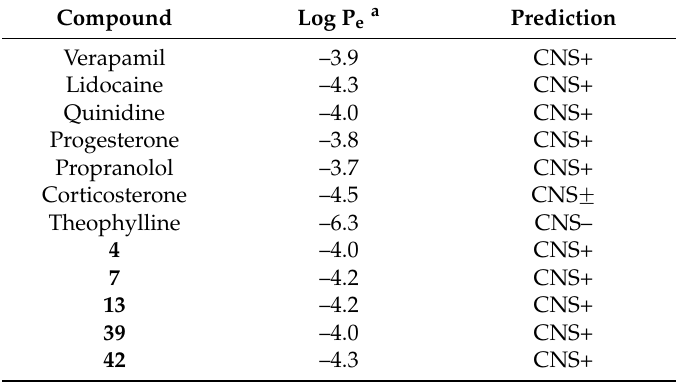
Table 2. Permeability (log P e ) in the PAMPA-BBB assay for commercial drugs and the selected compounds with prediction of their BBB penetration. Compound Log P e a Prediction